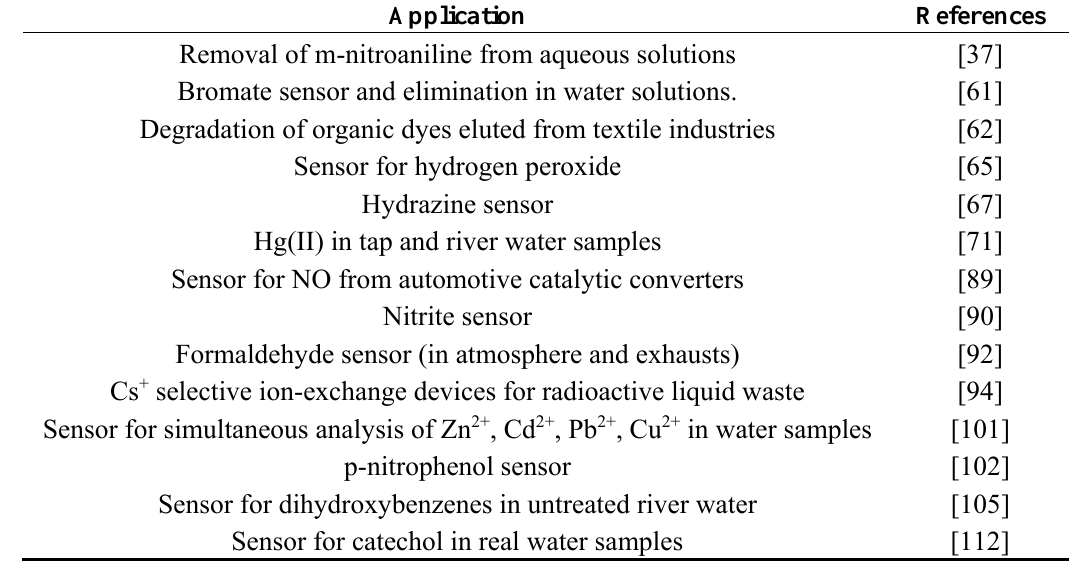
Table 3. Examples of environmental applications of the reviewed